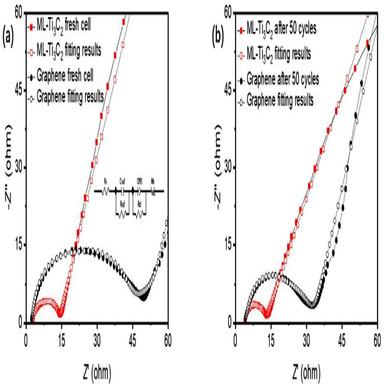
Electrochemical impedance spectroscopy and fitting results of (a) ML-Ti3C2/Li2S and Graphene/Li2S cathodes before cycling and (b) ML-Ti3C2/Li2S and Graphene/Li2S cathodes after 50 cycles.